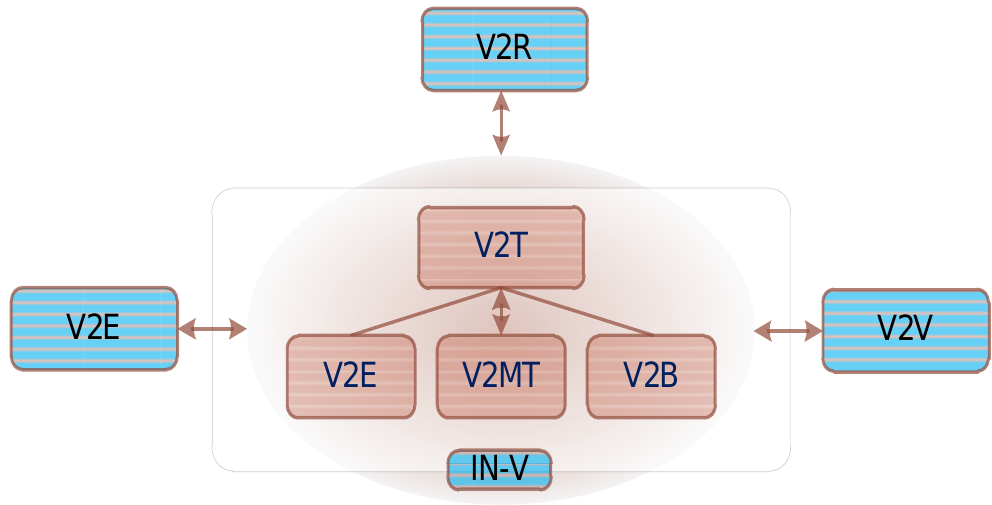
Figure 1. Communication model in V2X Scenario.